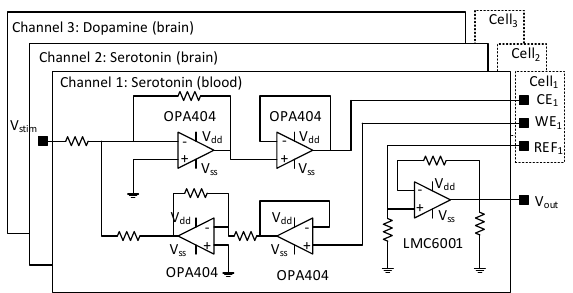
Figure 2. A three-channel potentiostat implanted on PCB. Each channel is Figure 4. A three-channel potentiostat implanted on PCB. Each channel is designed to detect one designed to detect one molecule (serotonine, dopamine 1 or dopamine 2). The input signal (V stim ) is shared between all potentiostats. V out is the molecule (serotonine, dopamine 1 or dopamine 2). The input signal (Vstim) is shared between all measured current. potentiostats. Vout is the measured